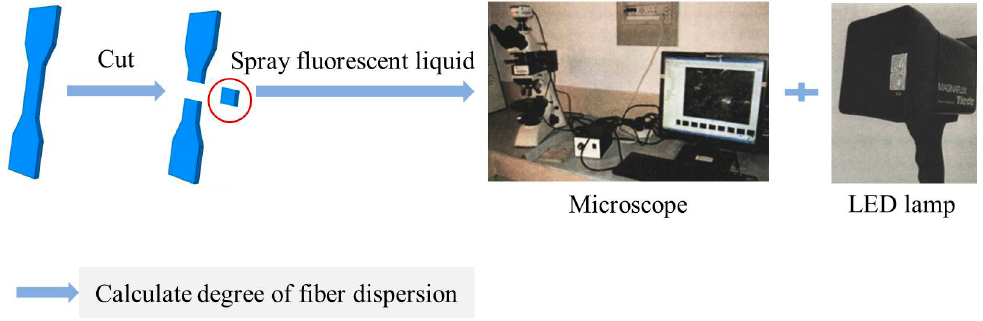
Figure 5. Test method fl ow of fi ber dispersion degree.